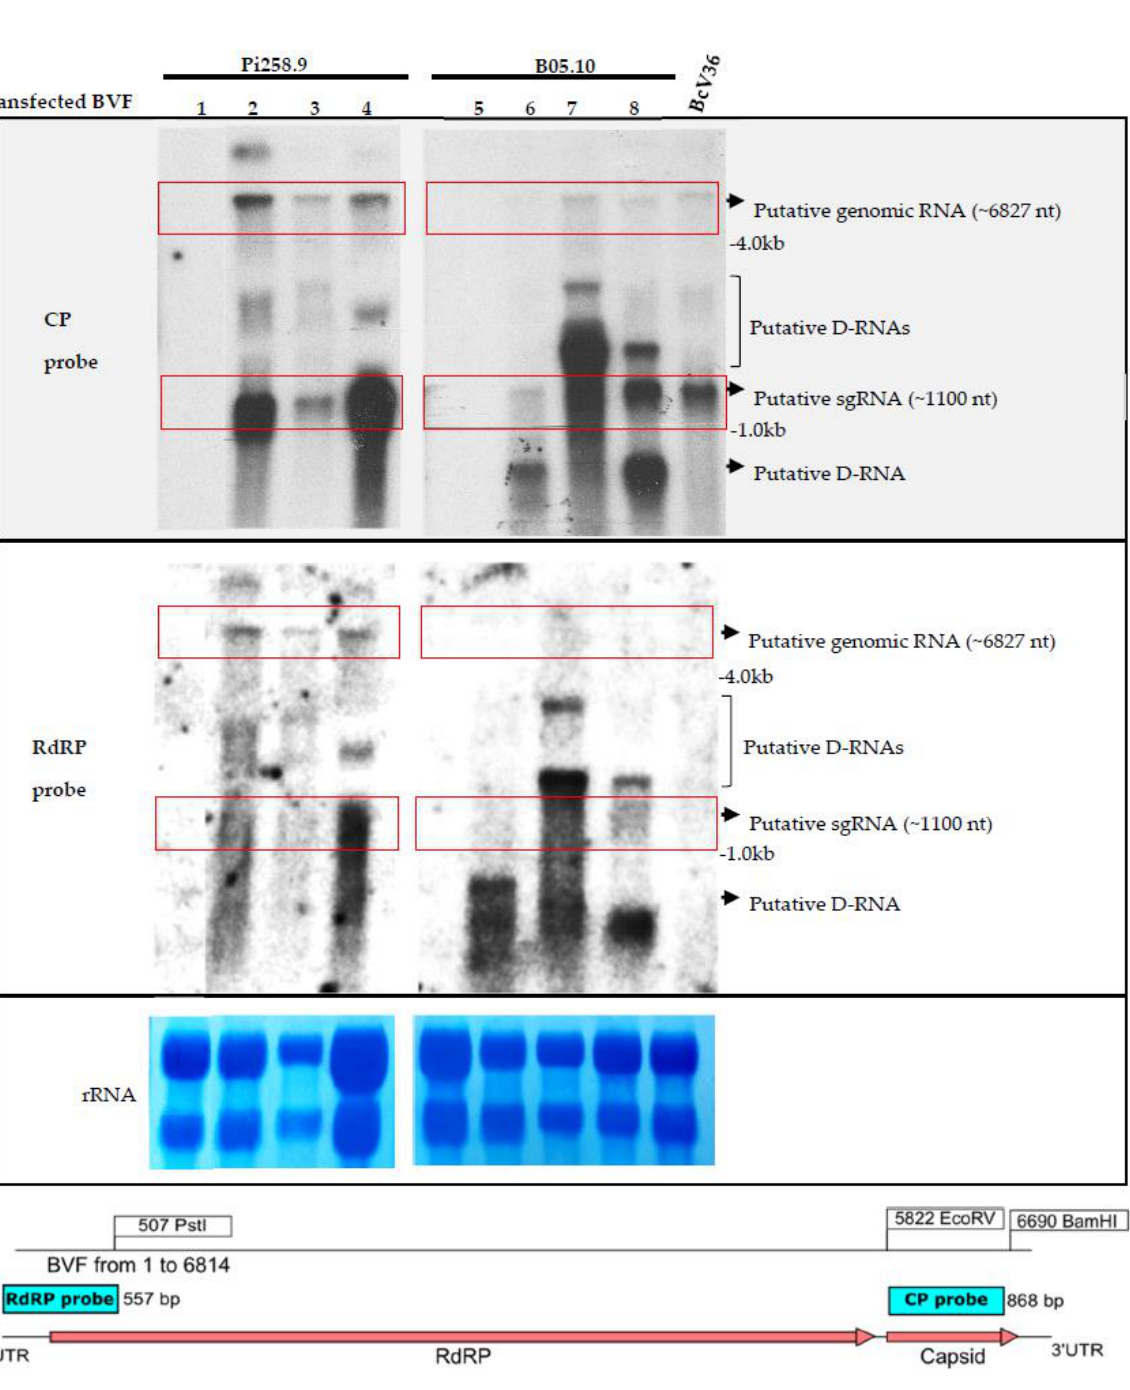
Figure 4. Detection of BVF full length and BVF CP-sgRNA. Northern blot hybridization analysis of total RNA preparations from mock mycelia and B. cinerea strain B05.10 and Pi258.9 infected mycelia using a CP and RdRP probes. Total RNA extracts from samples: 1. Pi258.9 non transfected strain; 2. Pi258.9 BVF transfected strain; 3. Pi258.9 monosporic 2 strain obtained from Pi258.9 BVF transfected strain after 5 days of incubation in PDB; 4. Pi258.9 monosporic 2 strain obtained from Pi258.9 BVF transfected strain after 3 days of incubation in PDB 5. B05.10 non transfected strain; 6. B05.10 BVF transfected strain; 7. B05.10 monosporic 1 strain obtained from B05.10 BVF transfected strain after 5 days of incubation in PDB; 8. B05.10 monosporic 1 strain obtained from B05.10 BVF transfected strain after 3 days of incubation in PDB; BcV36 strain natural infected with BVF. Red boxes indicate positions of the bands for BVF genomic RNA (~6827 nt) and putative sgRNA (~1100 nt). Ethidium bromide staining of the gel prior to transfer is shown as loading control (rRNA).